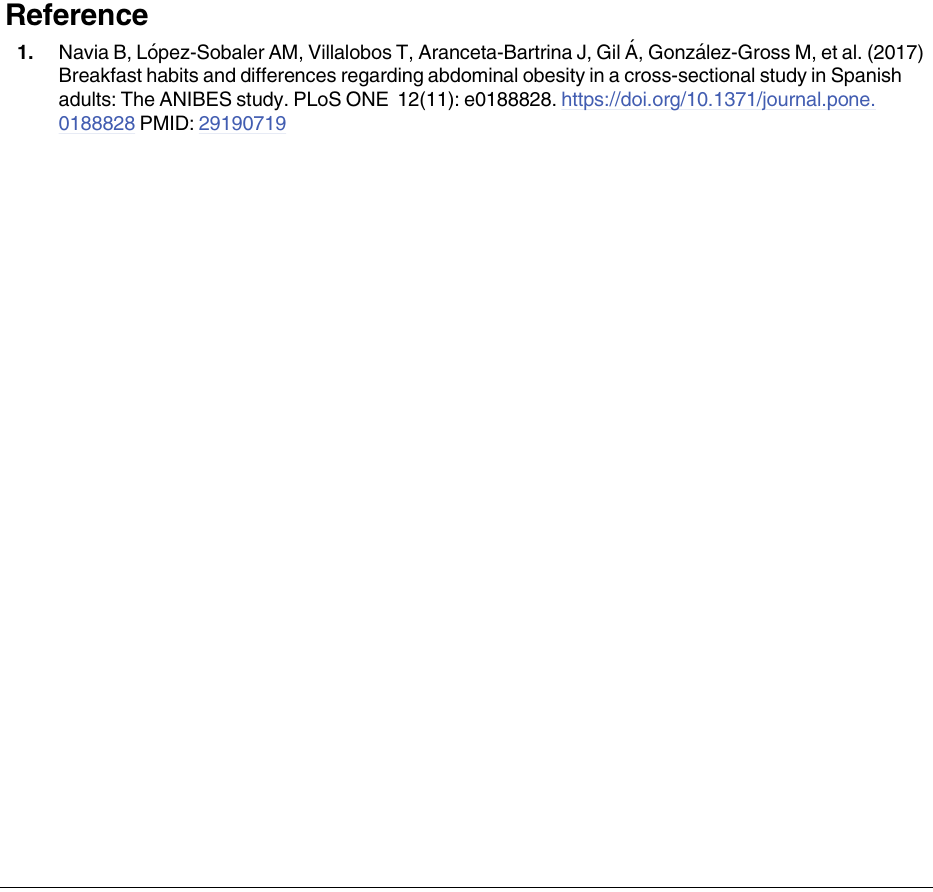
S2 Table. Foods consumed at breakfast (% consumers). Differences regarding WHtR cate- gories. Z test proportions. The differences are between the same gender groups. (cid:3) p <